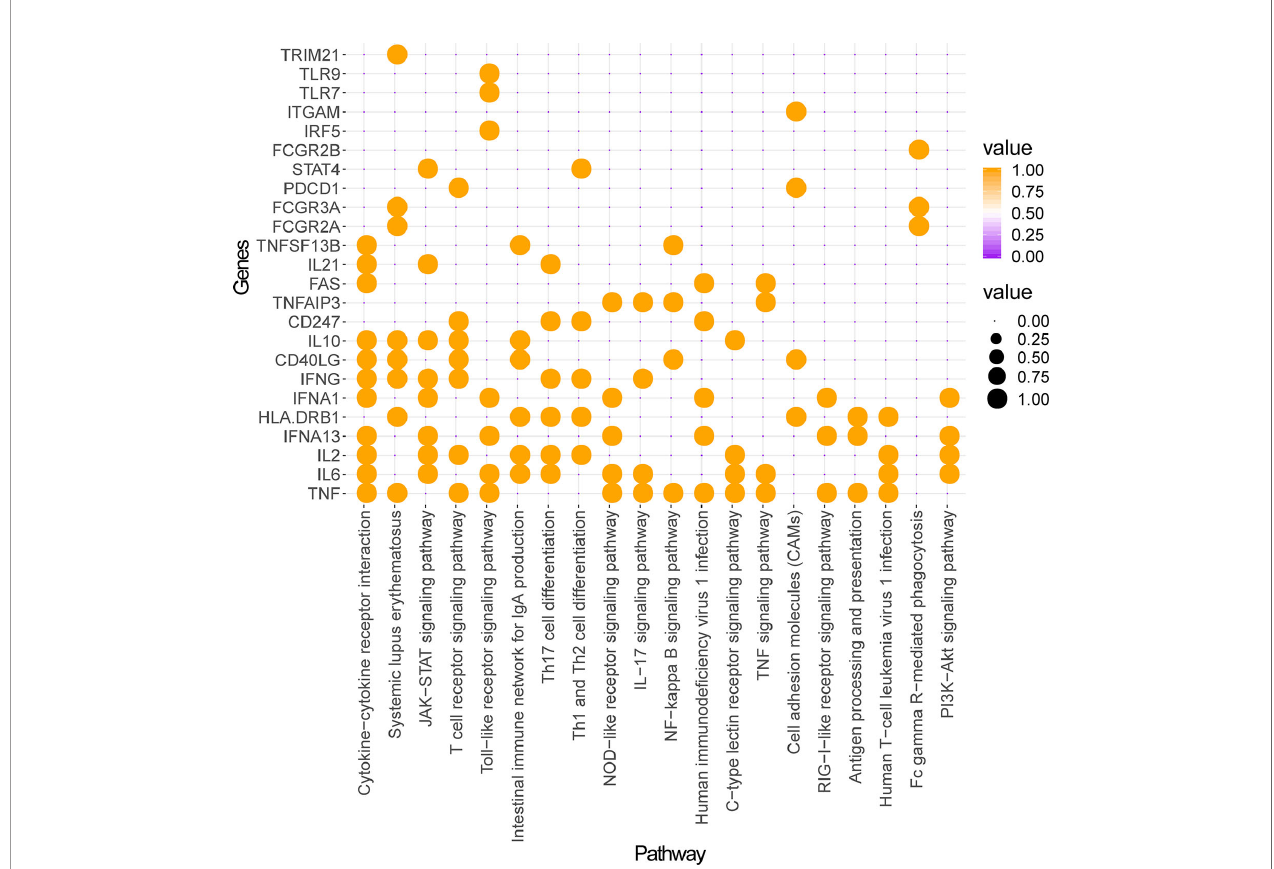
FIGURE 3 | Pathway enrichment analysis of top 30 weighted genes of SLE. The ordinate represents genes and the abscissa represents enriched pathways. Orange nodes represent genes enriched in a given pathway and no nodes represent genes not enriched in this